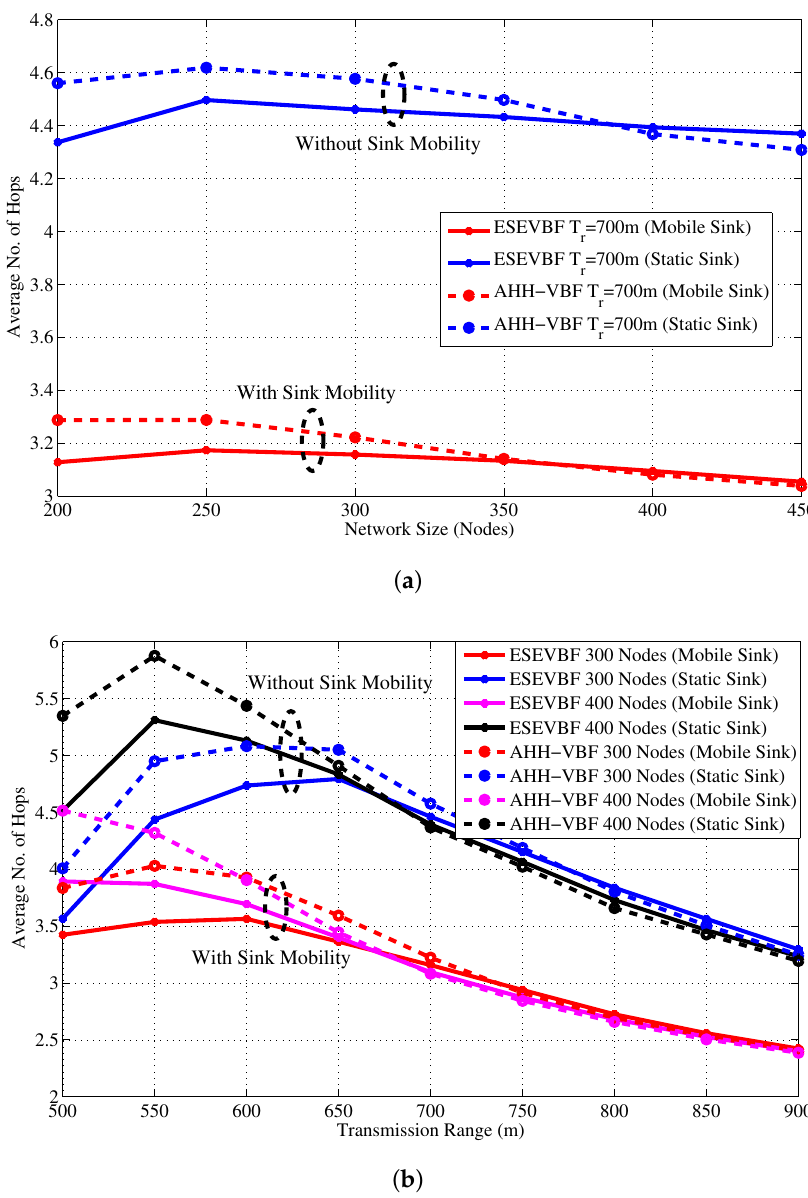
Figure 20. Average number of hops the data message needs to traverse in network to reach static and mobile Sink ( a ) Network with varying size ( b ) Network with varying transmission